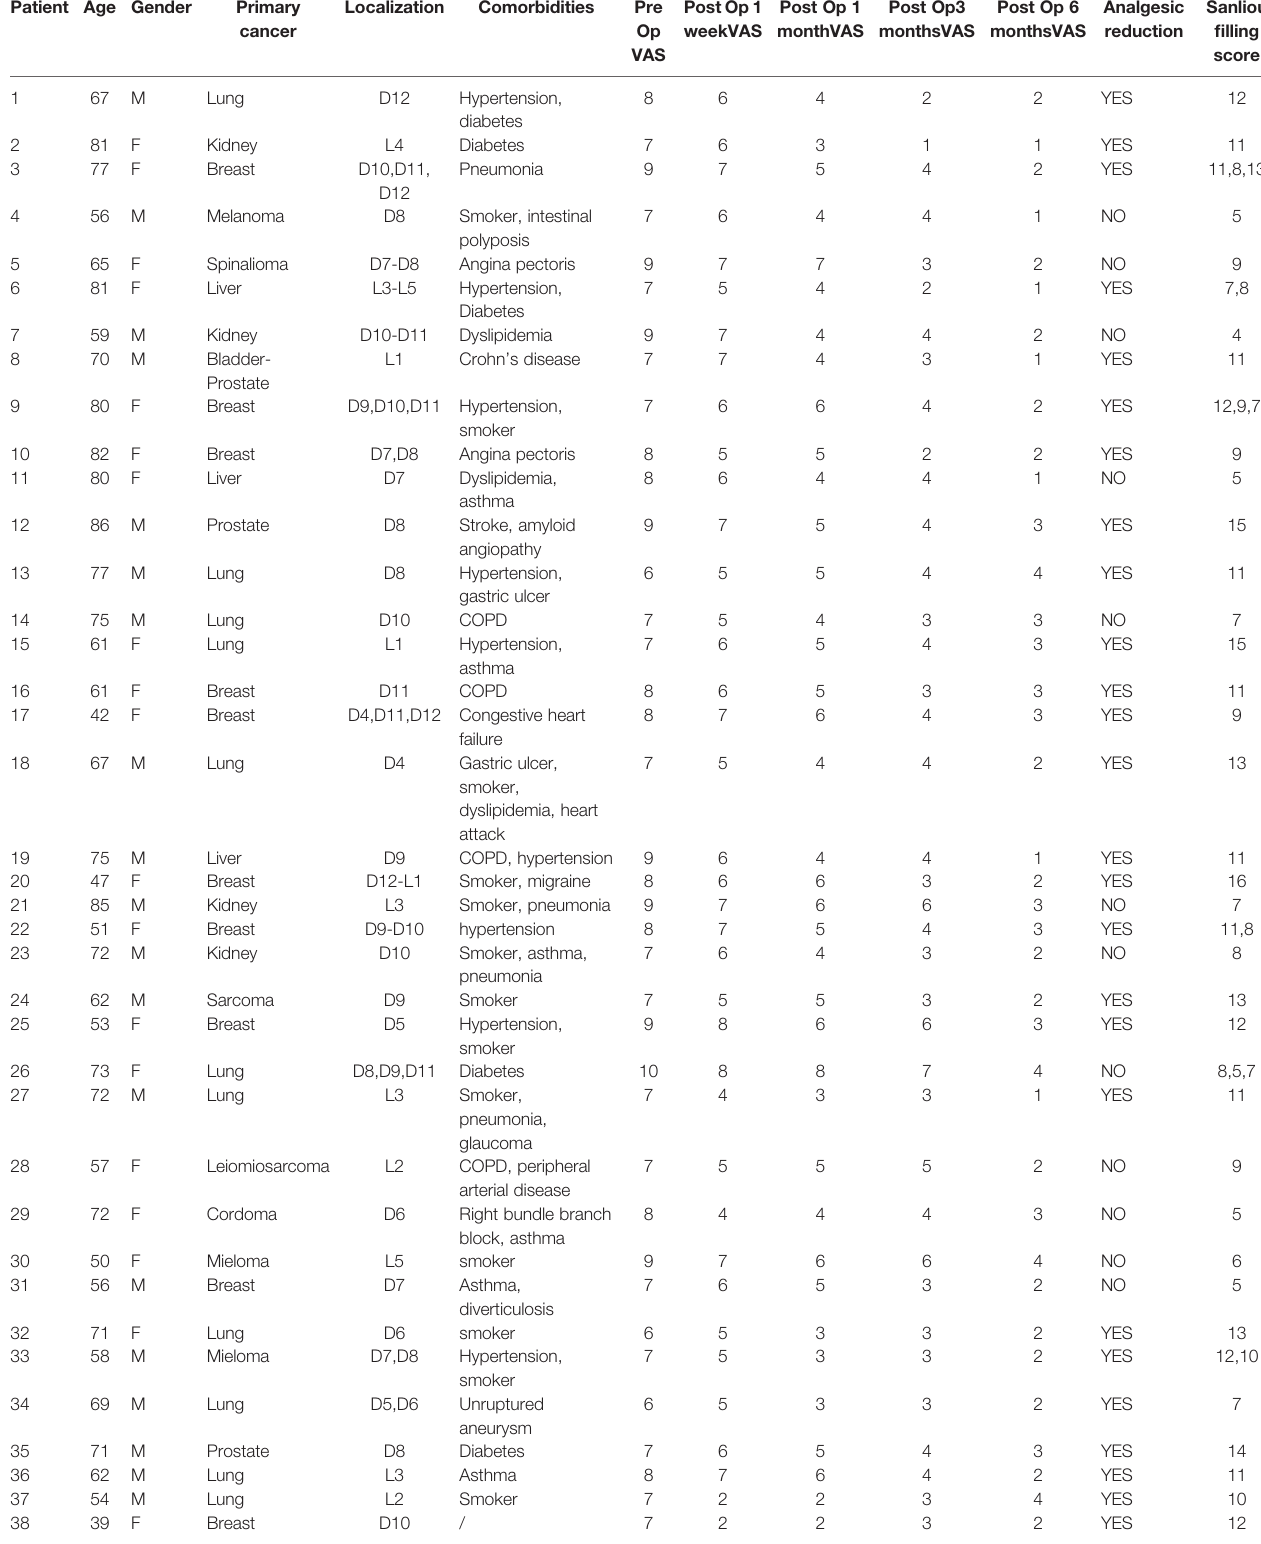
TABLE 1 | Demographic data of patients selected for this clinical series. Patient Age